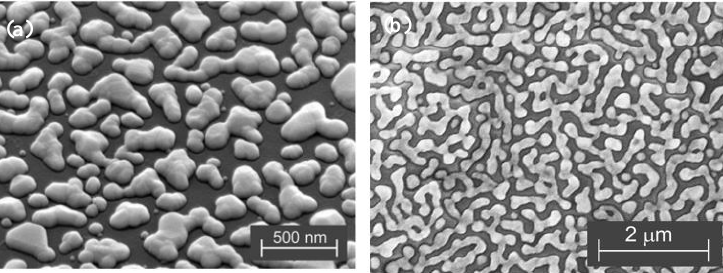
Figure 6. Scanning electron microscope (SEM) micrographs of nanosilver films: ( a ) heat treatment in air; ( b ) laser sintering. Reproduced with permission from [142].